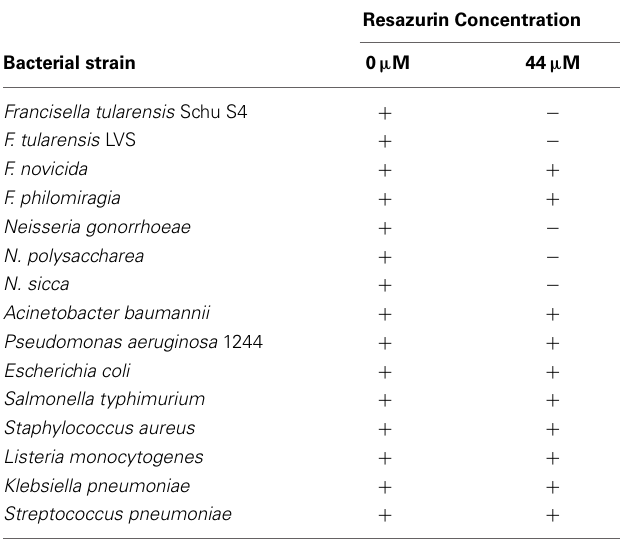
Table 2 | Resazurin inhibits the growth of Francisella and Neisseria species on chocolate II agar.